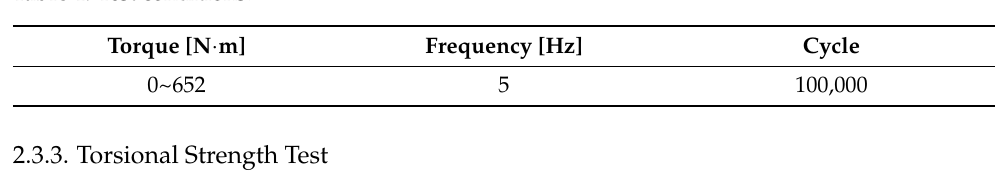
Table 4. Test conditions.